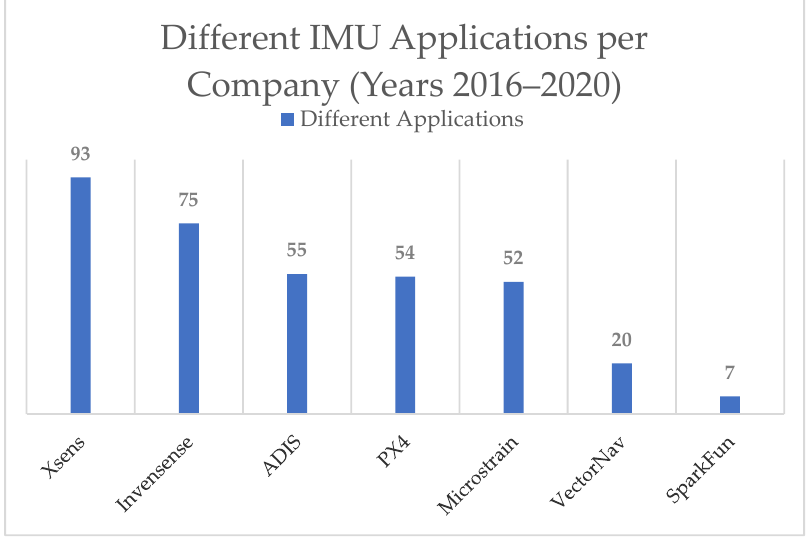
Figure 8. Total number of IMU applications per company in years 2016–2020.